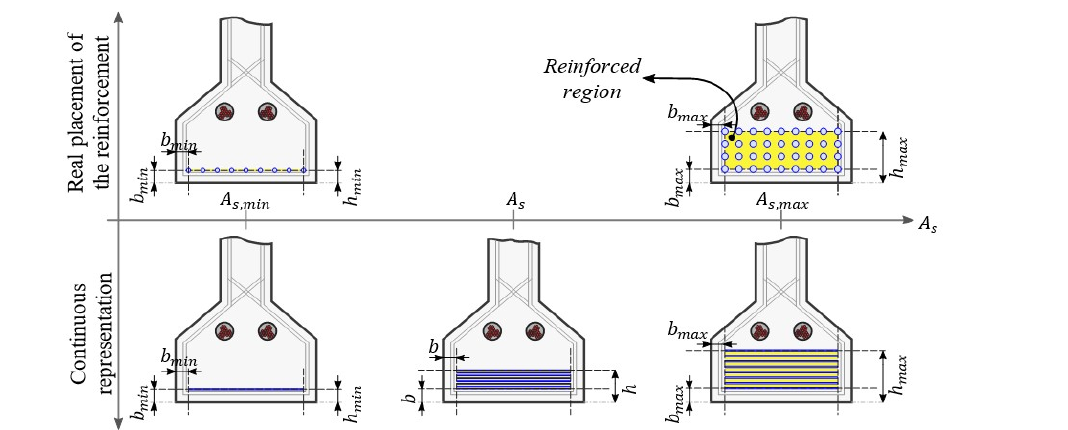
Figure 12. Real positioning and continuous representation of passive